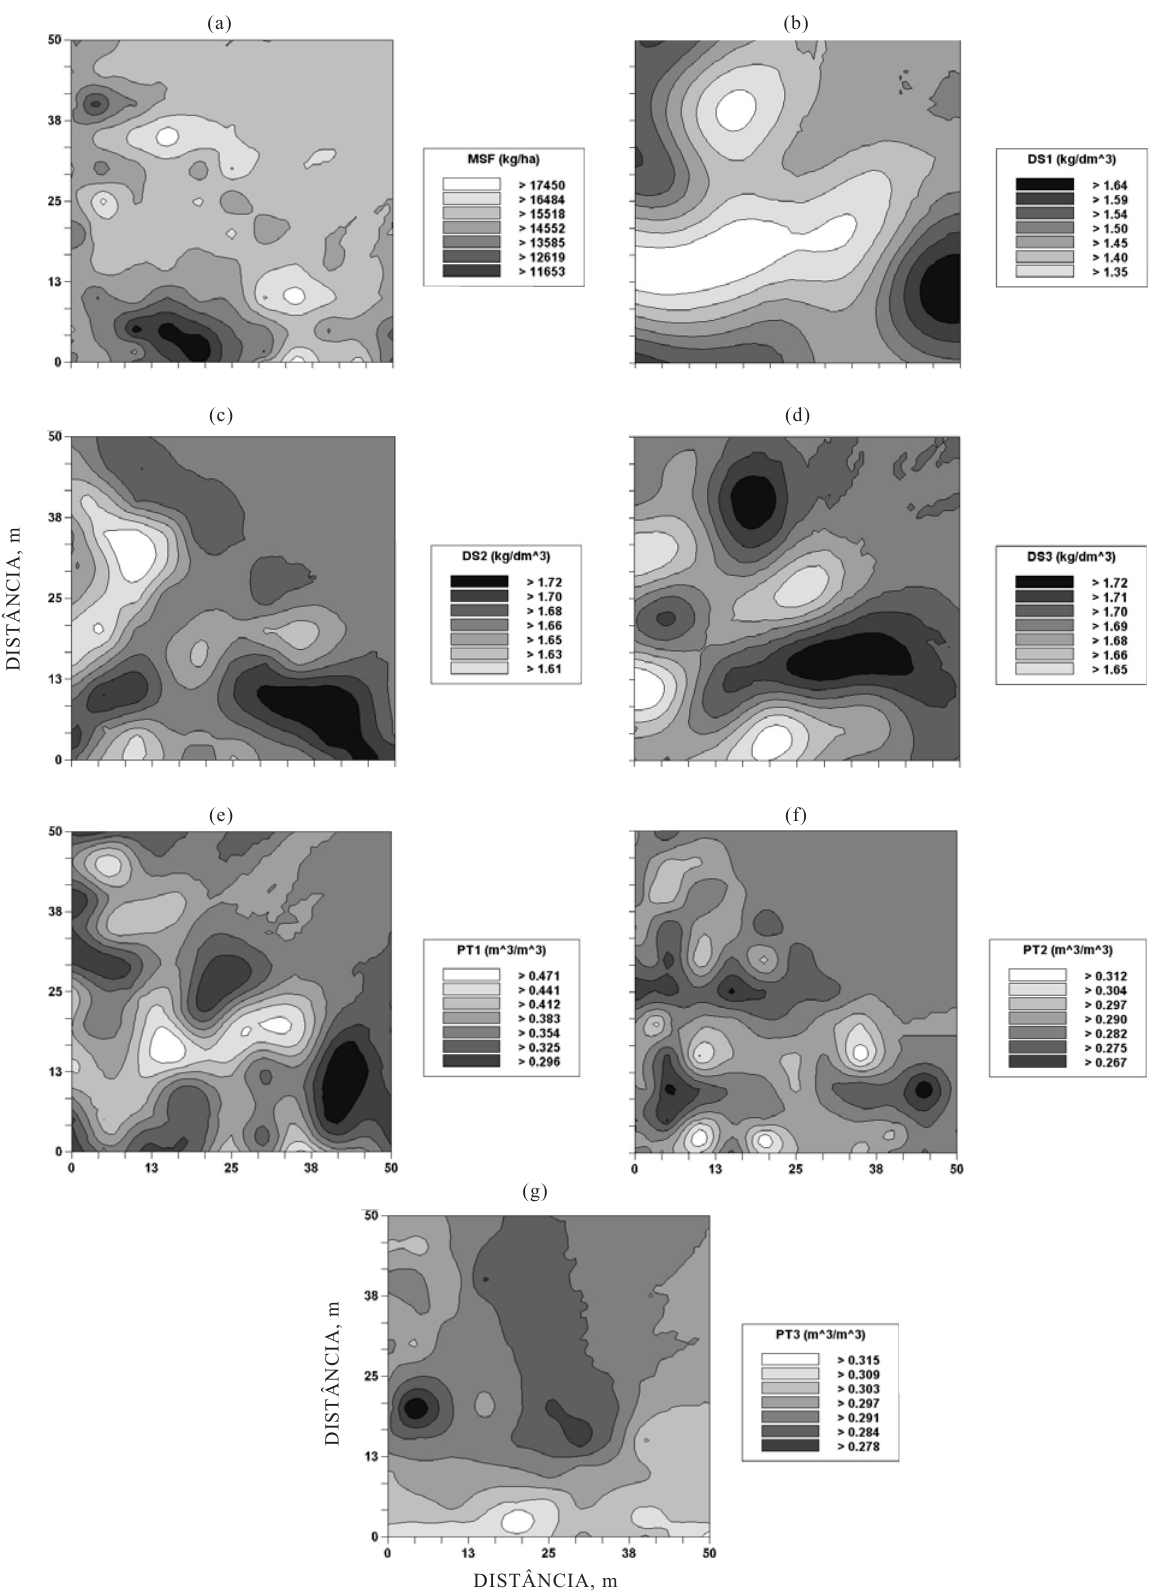
Figura 1. Mapas de krigagem da produtividade de matéria seca da forragem do milho, da densidade (DS1, DS2 e DS3) e da porosidade total (PT1, PT2 e PT3) de um Latossolo Vermelho distrófico de Pereira Barreto